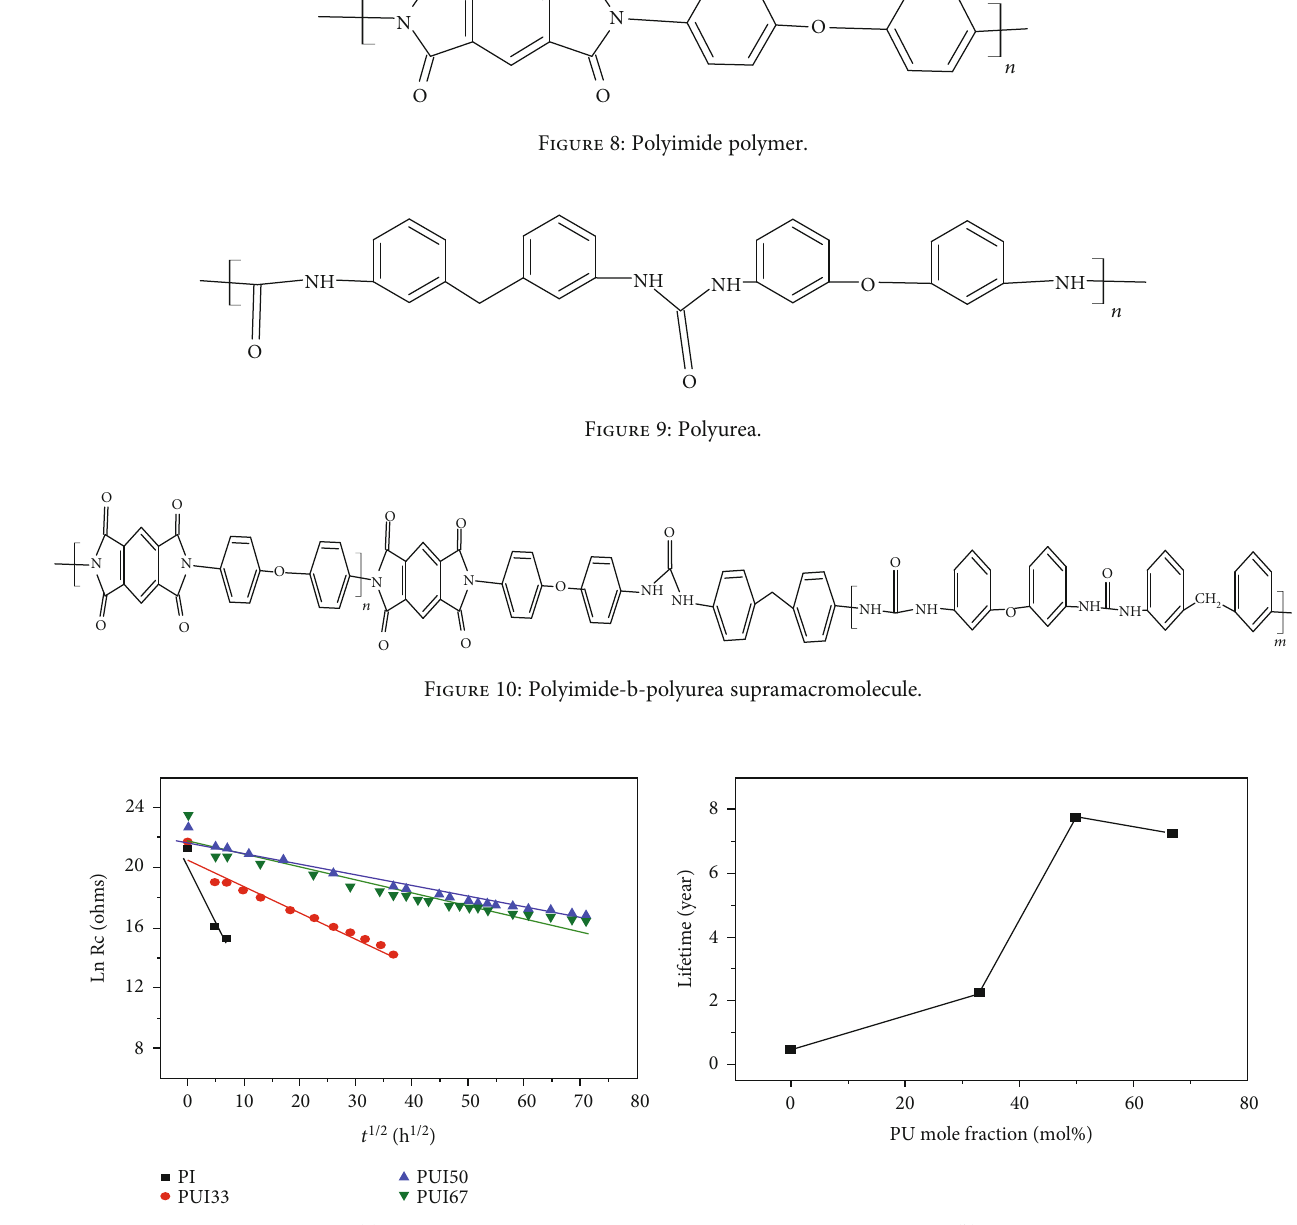
Figure 11: (a) The projected lifetimes of poly(urea-imide) coatings with varying concentrations of polyurea applied to aluminum. (b) The coating lifetime compared to the % mole fraction of polyurea. Courtesy of Feng and Iroh